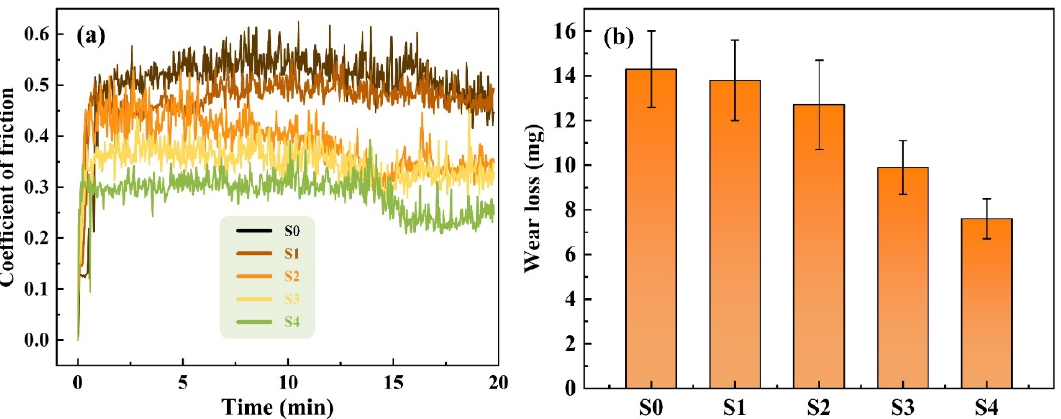
6 of 8 Figure 4. Microhardness histograms of as-printed S0-S4 samples in the lateral and top sections. 3.3. Wear Behavior The effect of SiC reinforcement on the wear resistance of as-printed AMCs was in- vestigated, and the results are shown in Figure 5. The coefficient of friction (COF) curves are shown in Figure 5a. COF curves showed a similar evolution, characterized by dramatic fluctuations and gradually decreasing with time. Fluctuations might be due to cracks and SiC reinforcement, which could lead to the stripping of the matrix and reinforcement from the sample during friction. The COF curves tended to be stable as the debris with poor binding to the matrix gradually fell off. The average COF values of S0 to S4 samples were 0.507, 0.473, 0.389, 0.348, and 0.288, respectively. The weight loss of the as-printed materi- als is shown in Figure 5b. The average weight loss for the as-printed S0 to S4 samples were 14.3 ± 1.7 mg, 13.8 ± 1.8 mg, 12.7 ± 2 mg, 9.9 ± 1.2 mg, and 7.6 ± 0.9 mg, respectively. Com-